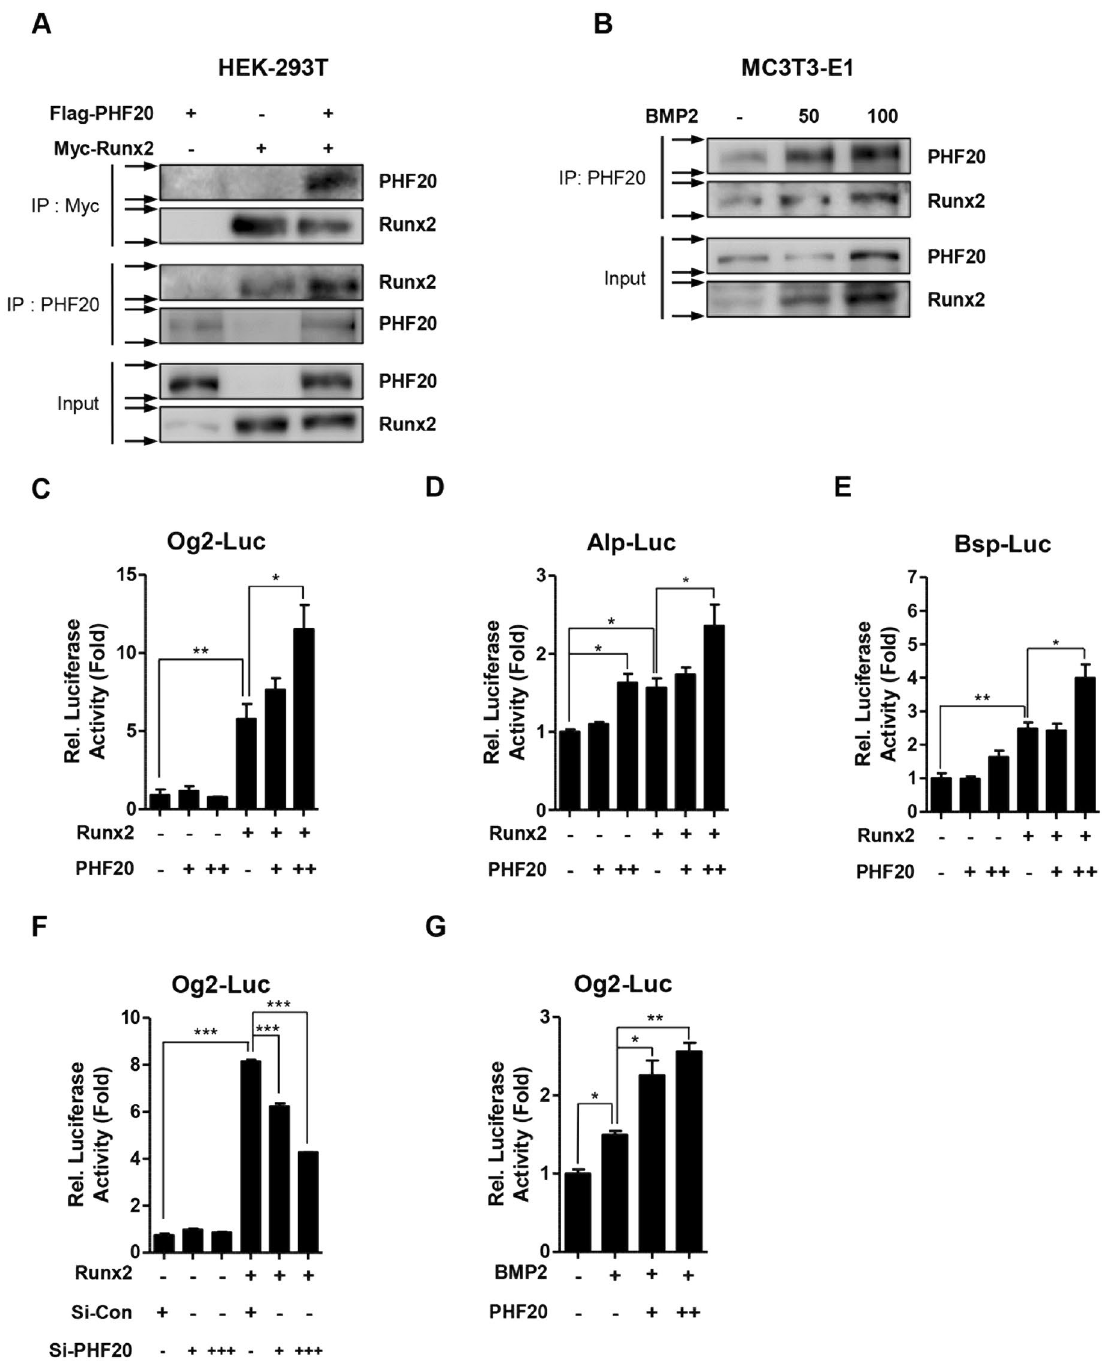
Figure 4. PHF20 regulates Runx2 transactivity through physical interaction with Runx2. HEK-293T cells were transiently transfected with Flag-PHF20 and Myc-Runx2 for 48 hours. Immunoprecipitation was performed with Myc or PHF20 antibody followed by immunoblotting with PHF20 and Runx2 antibody ( A ). MC3T3-E1 cells were treated with BMP2 for 3 days and immunoprecipitated to confirm endogenous protein binding ( B ). Arrows ( → ) indicate cropping lines and blots were obtained under the same experimental conditions ( A , B ). PHF20 regulates luciferase activities of osteoblast specific marker genes ( C – G ). MC3T3-E1 cells were transiently transfected with Og2-Luc (200 ng) ( C ), Alp-Luc (200 ng) ( D ), Bsp-Luc reporter (200 ng) ( E ), plasmid with Runx2 (100 ng) construct and/or PHF20 ( + , 200 ng; ++ , 600 ng) construct. Luciferase activities of Og2- Luc by si-Control and si-PHF20 ( + , 30 nM; +++ , 90 nM) treatment were measured ( F ). Luciferase activities of Og2-Luc were increased by BMP2 (100 ng/ml) and PHF20 ( + , 200 ng; ++ , 600 ng) ( G ). At 12 hours after transfection, cells were treated with or without BMP2 for 48 hours. After transfection, luciferase assay was performed. Results are expressed as fold activity relative to the control ( C – G ). Values are means ± SEM (n = 3). * p < 0.05, ** p < 0.01 and *** p < 0.001 compared to the indicated